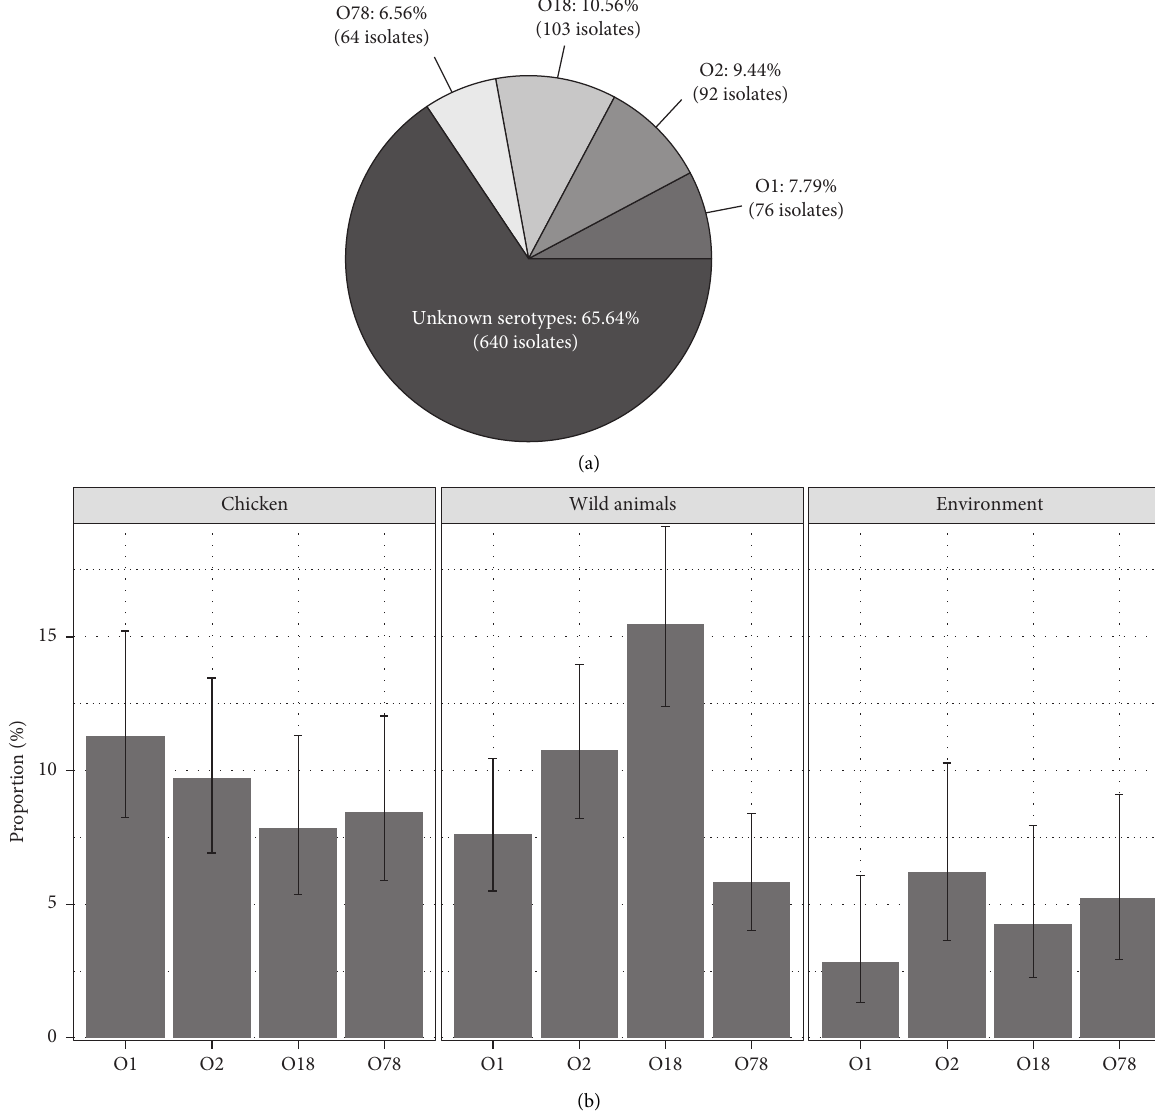
Figure 2: A pie chart showing the distribution of serotypes O1, O2, O18, and O78 per all E. coli isolates (a) and bar graphs showing proportions of serotypes O1, O2, O18, and O78 per chicken, wild animals, and environment (b). The error bar indicates 95% confidence